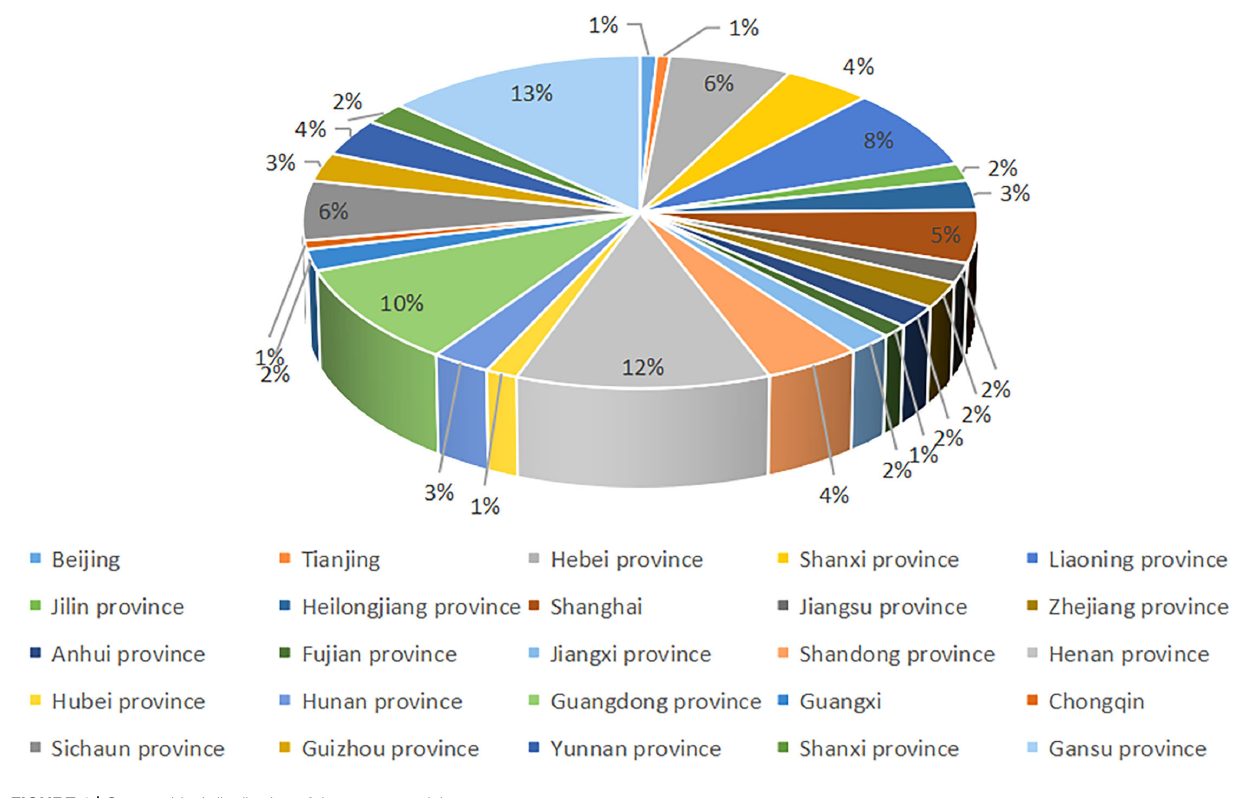
FIGURE 1 | Geographical distribution of the survey